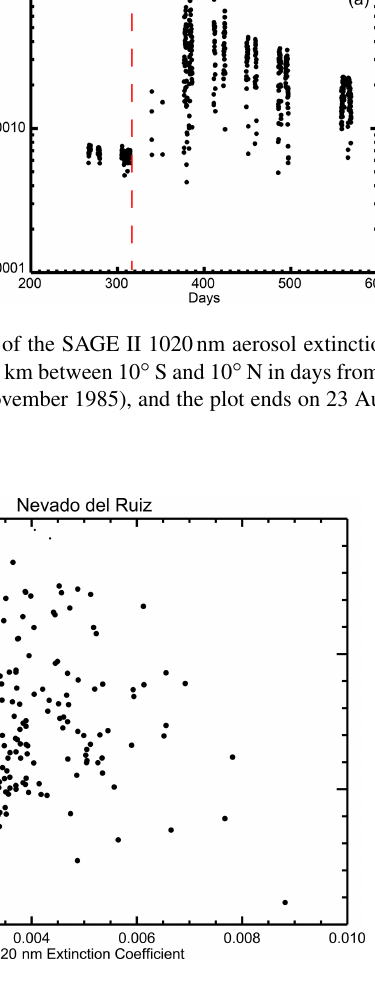
Figure 6. Same data as shown in Fig. 4 except averaged in temporal data clusters. In this figure, extinction coefficient is the solid line and the extinction coefficient ratio is the dotted line. The date of the eruption is denoted by the vertical red dashed